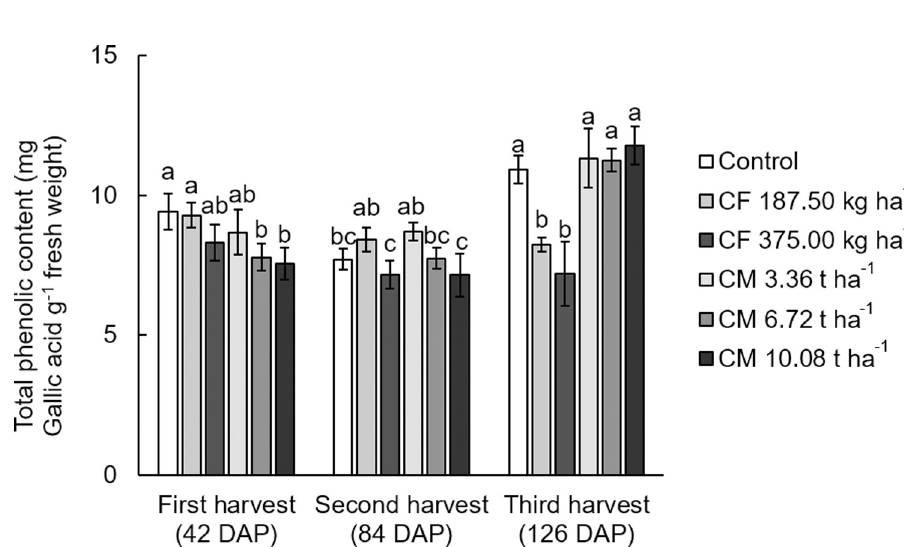
Fig 3. Total phenolic content (mg Gallic acid g -1 fresh weight) in the above-ground (leave and stem) of white mugwort under the fertilizer treatments. The different letters above the bars indicate statistically significant differences by Duncan’s multiple range tests (p < 0.05) within each harvest. CF = chemical fertilizer (complete fertilizer 25-7-7 grade + urea 46-0-0 grade); CM = chicken manure.